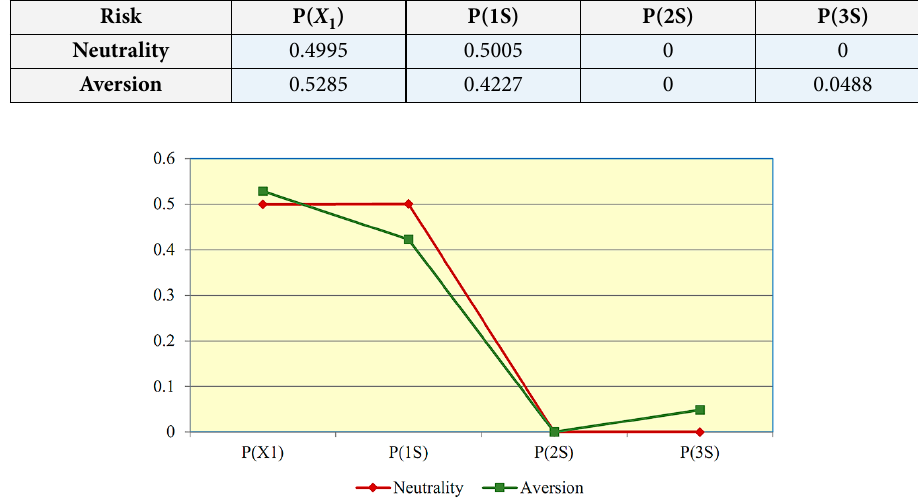
Figure 10. Equilibrium probabilities within a developing product